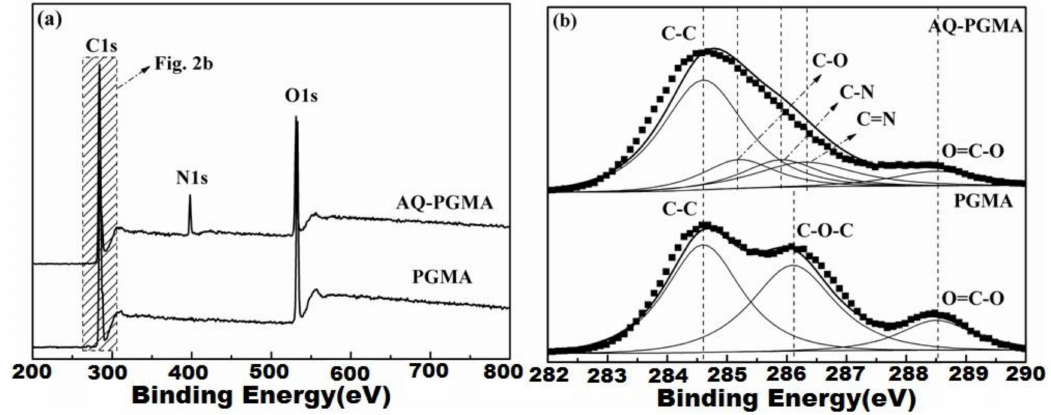
Figure 2. X-ray photoelectron spectroscopy (XPS) survey scan ( a ) and C 1s spectra ( b ) of PGMA and